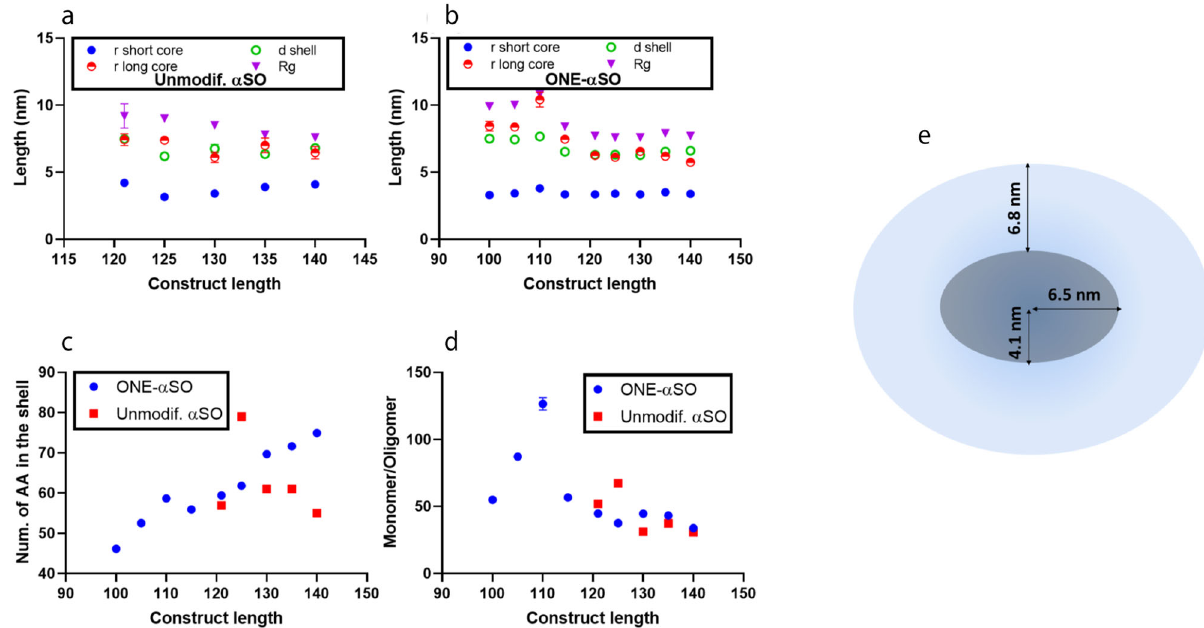
Fig. 3 Properties of ONE-modi fi ed and unmodi fi ed oligomers of truncated α SN mutants. a – d SAXS analysis of C-terminal truncated α SN oligomers. a , b The data with a previously developed model for α SO140 suggest similar ellipsoidal shapes for all oligomers, i.e., a dense core and diffuse shell. However, parameters related to the shape of core and shell change in different ways in truncated constructs of unmodi fi ed versus ONE-modi fi ed α SOs. c The number of amino acids in the shell fl uctuate in unmodi fi ed α SOs but decrease with truncation in ONE-modi fi ed α SOs. d There is also an increase in the number of monomers per oligomer for both kinds of oligomers. Each point is the average of three replicates where error bars show standard deviations. e Schematic model of unmodi fi ed α SN FL oligomers based on SAXS 32 . A compact core is surrounded by a shell of more fl exible polypeptide